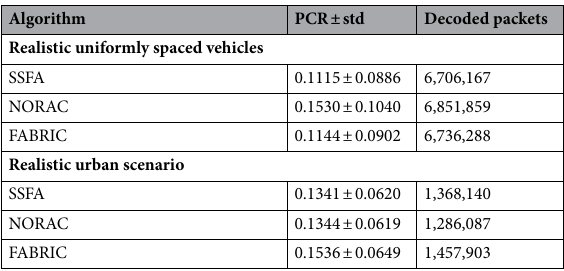
Table 3. Packet Collision Ratio and total number of decoded packets.